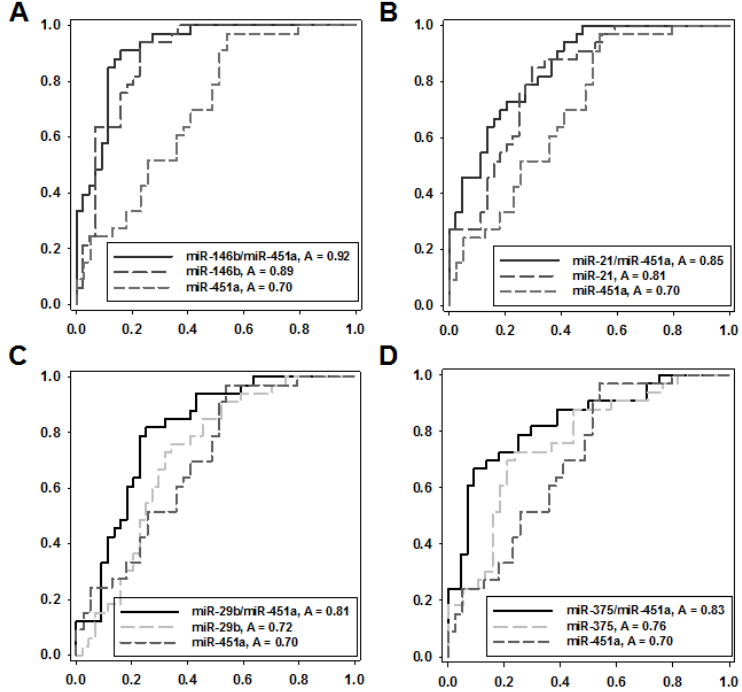
Figure 4. Diagnostic potency of individual miRNAs and amplification ratios of reciprocally dysregulated miRNAs pairs. ROC analysis was done with two groups of samples FA ( n .33) and FTC ( n .51). ( A ) miR-146b/miR-451a; ( B ) miR-21/miR-451a; ( C ) miR-29b/miR-451a; ( D ) miR-375/miR-451a.